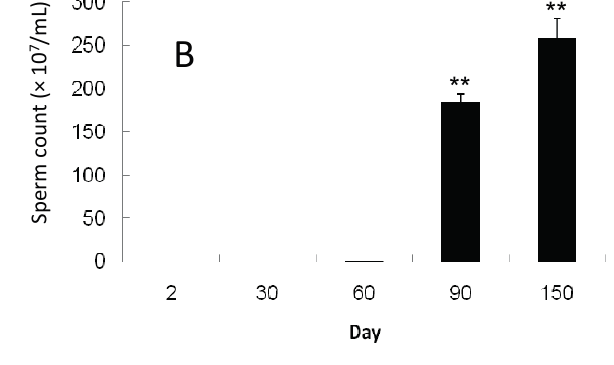
Figure 6. Expression of Stra8 mRNA in testis, the sperm count in cauda epidydimis, and testes weight of Meishan boars at various time points. ( A ) Expression of Stra8 mRNA; ( B ) Sperm count; and ( C ) Testes weight. Significant increases are denoted with “ **